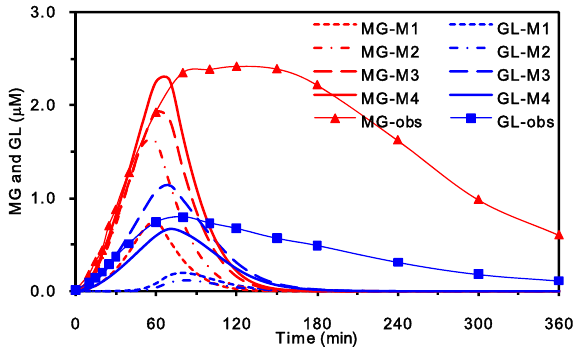
Fig. 8. Model-measurement comparison for methyl glyoxal (MG) and glyoxal (GL) abundances during the aqueous oxidation of iso- prene. The model simulations were performed with different MG production pathways. M1, only P1 pathway; M2, P1+P3 pathways; M3, P1+P2+P3 pathways (in P2 pathway: MG:GL=0.5:0.5); M4, P1+P2+P3 pathways (in P2 pathway: MG:GL=0.73:0.27). obs, observed